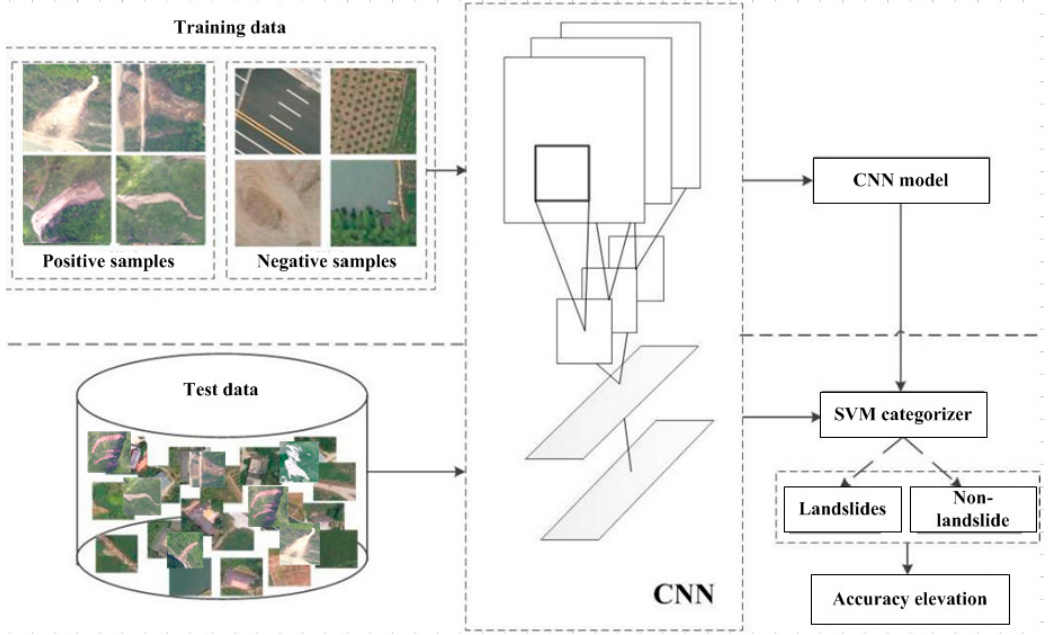
Figure 6. The flow chart of the convolutional neural network (CNN)-based landslide interpretation model.